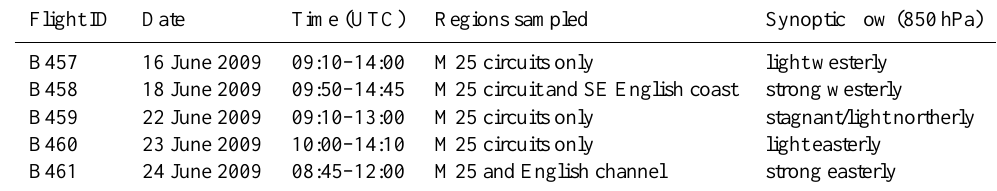
Table 1. Summary of flights and synoptic conditions during the EM25